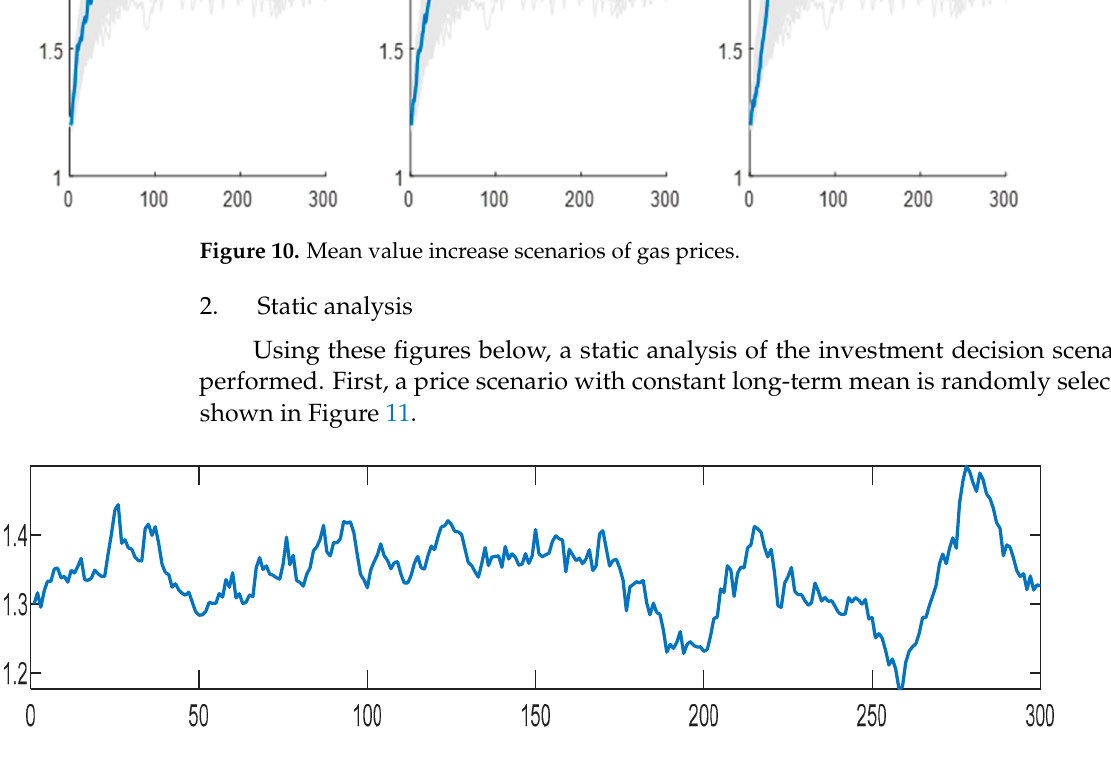
Figure 11. Selected constant mean value scenario of gas prices.